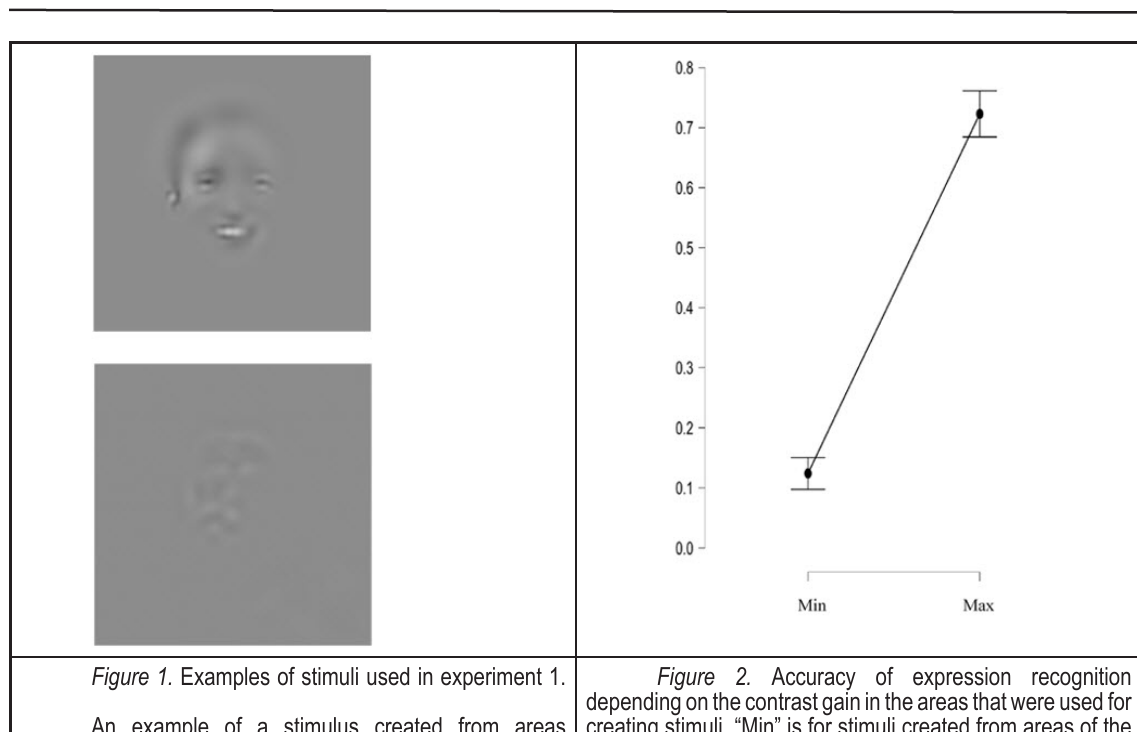
Figure 1. Examples of stimuli used in experiment 1. Figure 2. Accuracy of expression recognition depending on the contrast gain in the areas that were used for An example of a stimulus created from areas creating stimuli. “Min” is for stimuli created from areas of the of the initial face image with the highest contrast gain initial image with the lowest non-local contrast increase, “Max” (above). An example of a stimulus created from areas is for stimuli created from areas of highest contrast increase. with the lowest gain in non-local contrast (bottom). The y-axis shows the pro-portion of correct The regions used to create stimuli were selected in the range of spatial frequencies from 5.6 to 90.2 CPI.